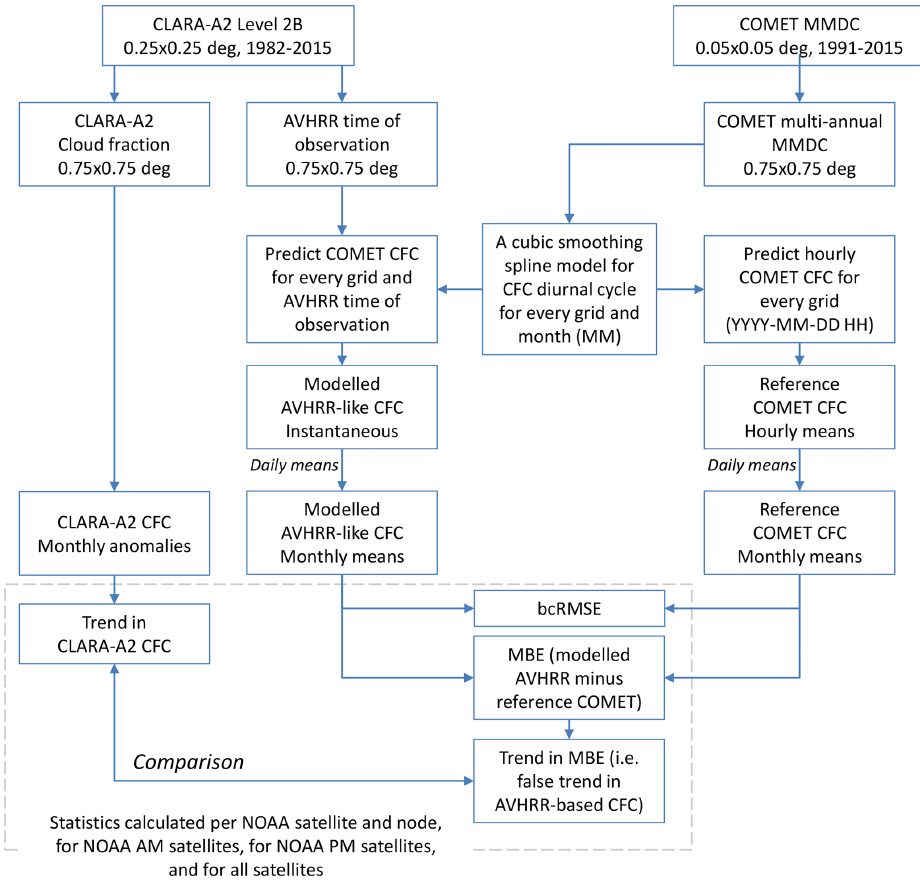
Figure 2. Flowchart of the applied methodology consisting of predicting COMET CFC for AVHRR observation times, deriving a COMET- based CFC reference, and calculating errors and the magnitude of spurious trends in AVHRR-based CFC caused by satellite orbital drift.